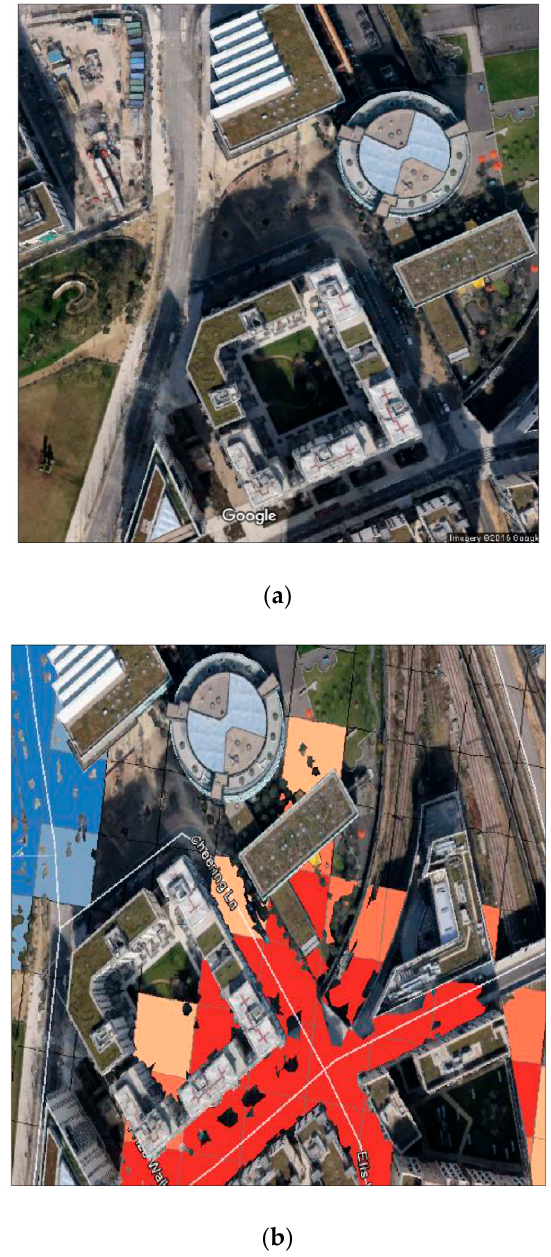
Figure 14. Detail of green roofs, East Olympic Village ( a ). Detail of hot spot location in East Olympic Village—hot spots indicated in red, cold spots in blue (ASTER—6 August 2015) ( b ). Contains Google Earth data, US Dept of State Geographer data SIO, NOAA, U.S. Navy, NGA, GEBCO © 2017 Google, © 2009 GeoBasis DE/BKG.